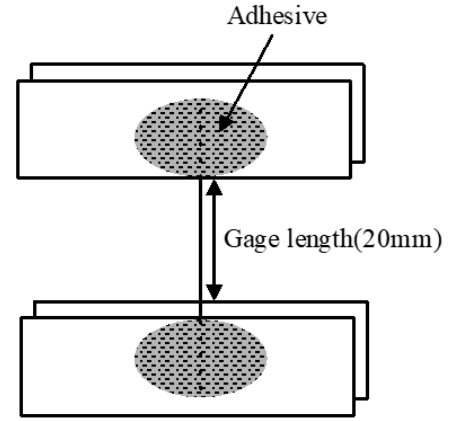
Figure 1. Schematic of the specimen for the tensile test.